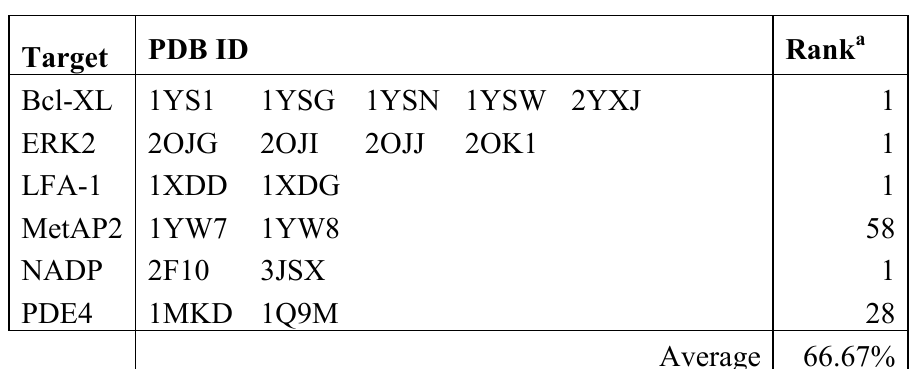
Table 2. Prediction results with multiple target protein